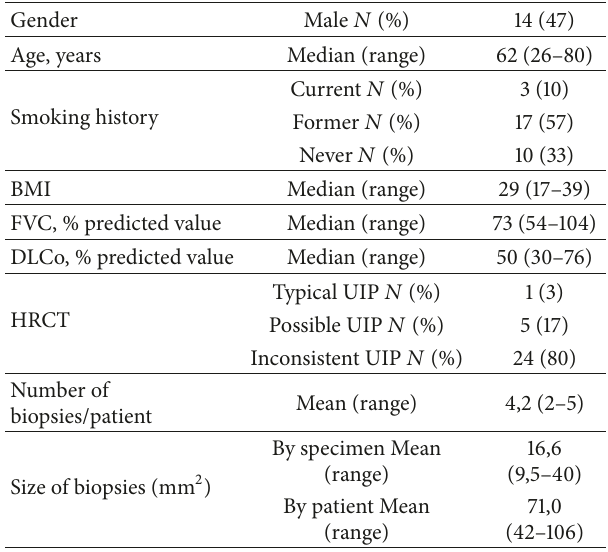
Table 1: Clinical characteristics of the patients ( 𝑁 = 30 ).